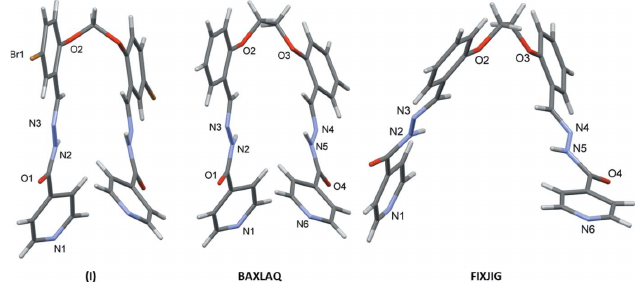
Figure 11 The molecular structures of compounds (I), BAXLAQ (Mahmoudi et al. , 2017) and FIXJIG (Tai et al. , 2004).